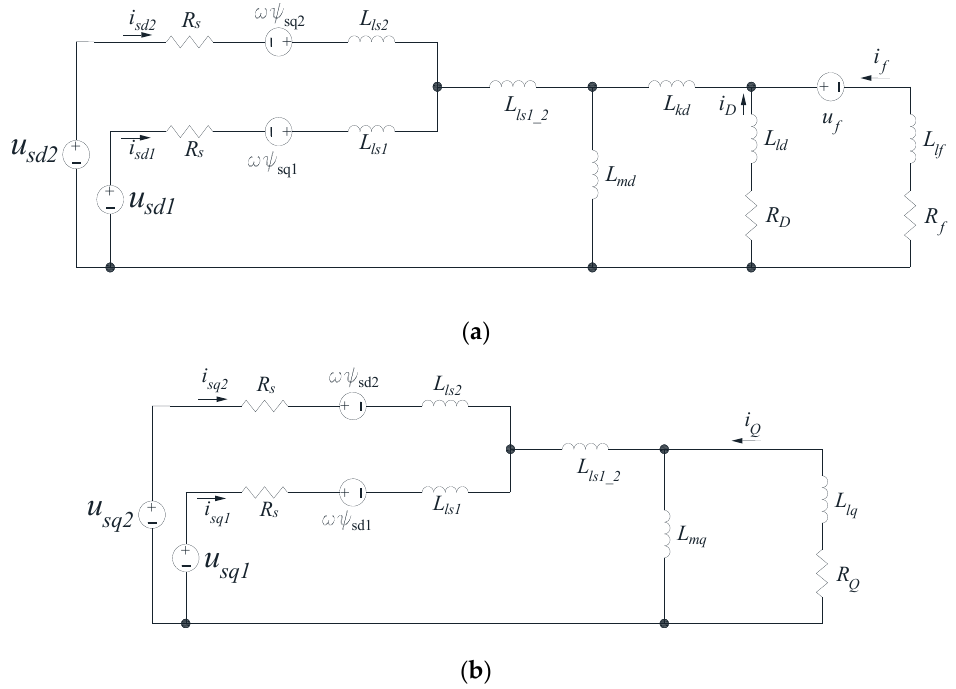
Figure 1. Ref. [33] Equivalent circuits for the d - and q -axis of an EESM with double stator winding: ( a ) d -axis equivalent circuit; ( b ) q -axis equivalent circuit. The parameters of the equivalent circuits are as follows: R s is stator resistance, R D and R Q are the d - and q -axis damper winding resistances, R f is the field resistance, L ls 1 and L ls 2 are the stator leakage inductances, L kd is the Canay inductance, L ls 1_2 is the mutual leakage inductance between stator windings, L md and L mq are the d - and q -axis magnetizing inductances, L lsD and L lsQ are the d - and q -axis damper winding leakage inductances, (cid:1838) (cid:3039)(cid:3033) is the field winding leakage inductance, (cid:1873) (cid:3046)(cid:3031) and (cid:1873) (cid:3046)(cid:3044) are the d - and q -axis